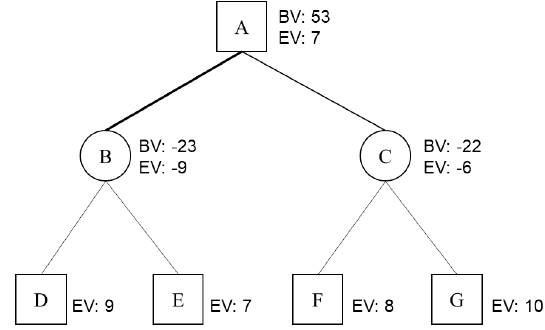
Figure 6. An example using iterative optimal minimax (IOM)